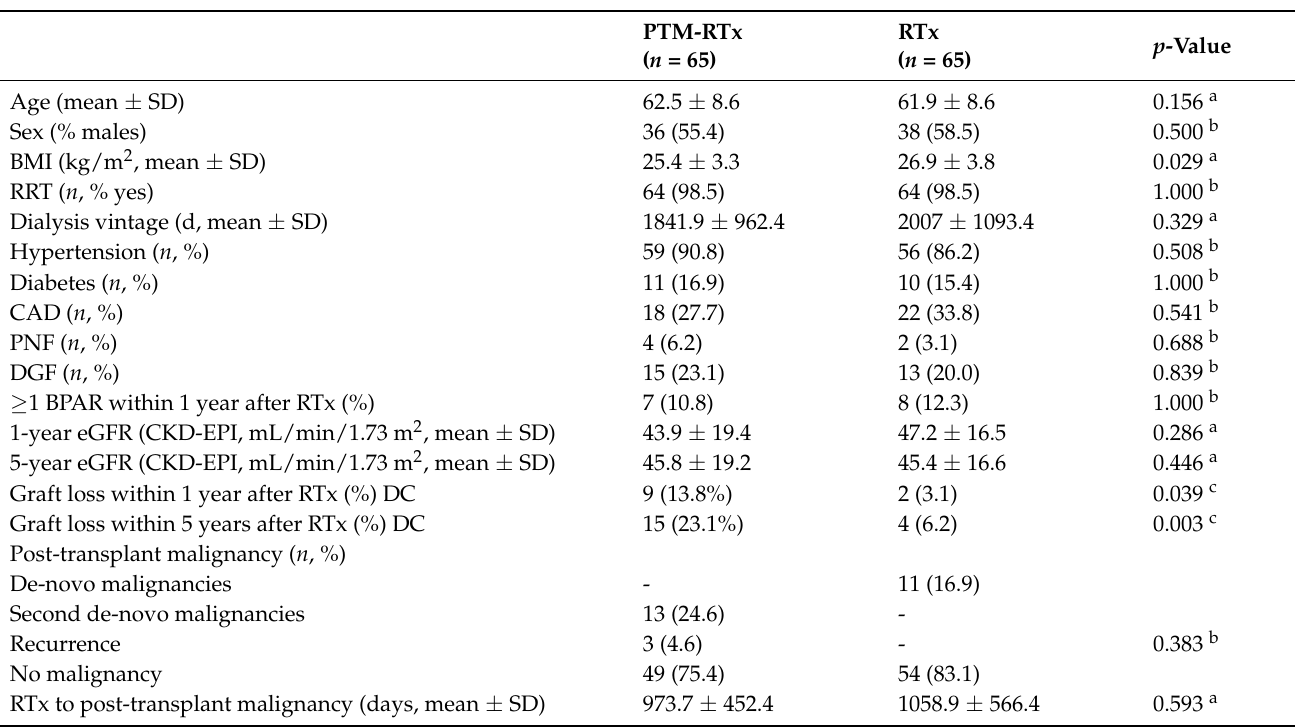
Table 4. Baseline recipient characteristics stratified PTM-RTx or RTx, matched by age, sex and underlying end stage renal